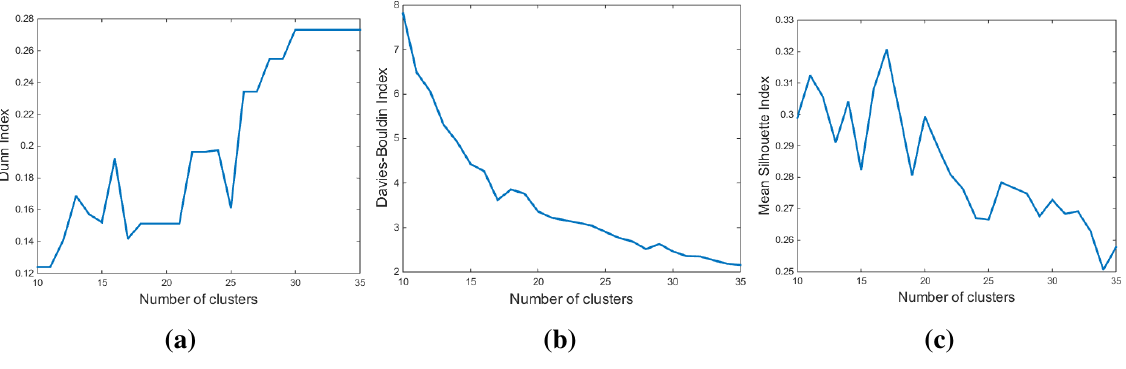
Figure 7. Validating the quality of the clusters produced by K -means algorithm in site